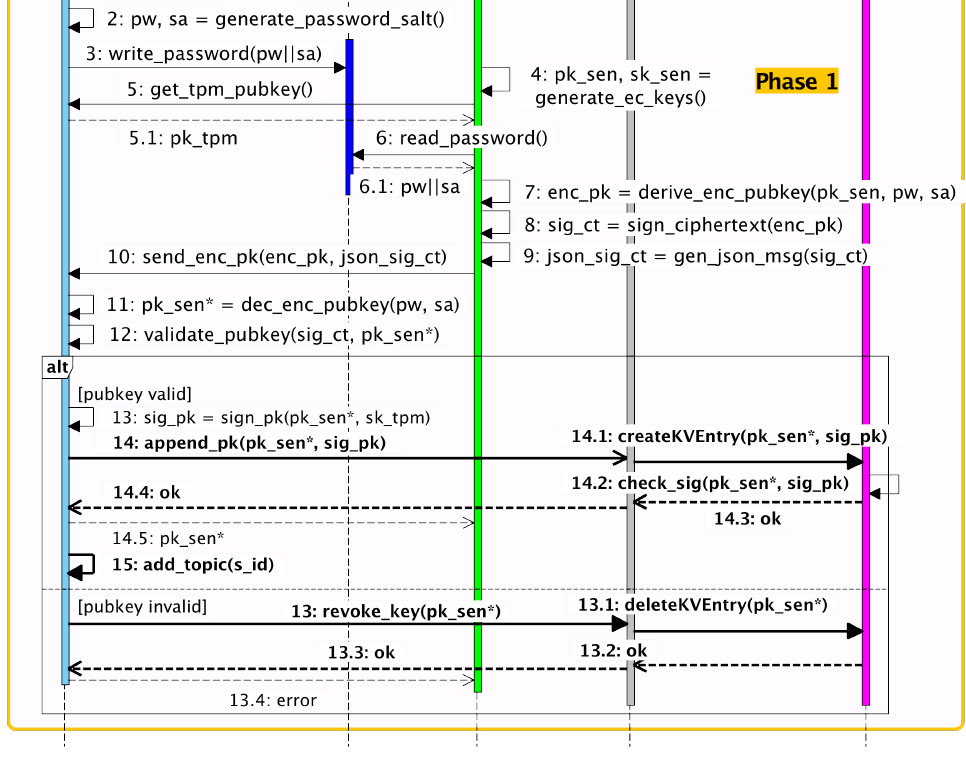
Figure 2. NFC-KE Phase 1 HLF extension [25].